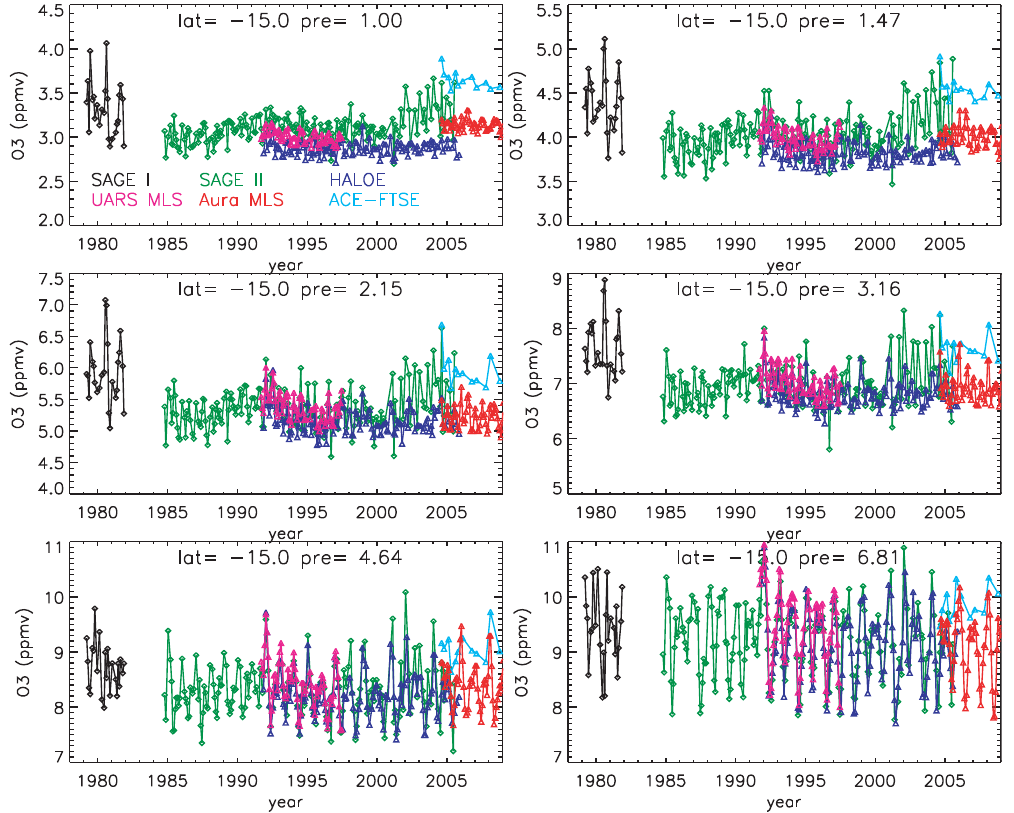
Figure 17. Time series of monthly zonal mean O 3 for 10–20 ◦ S between 1 and 6.8hPa (with pressure values given by “pre”) from SAGE I, SAGE II, HALOE, UARS MLS, Aura MLS, and ACE-FTS, all color-coded following the legend in top left